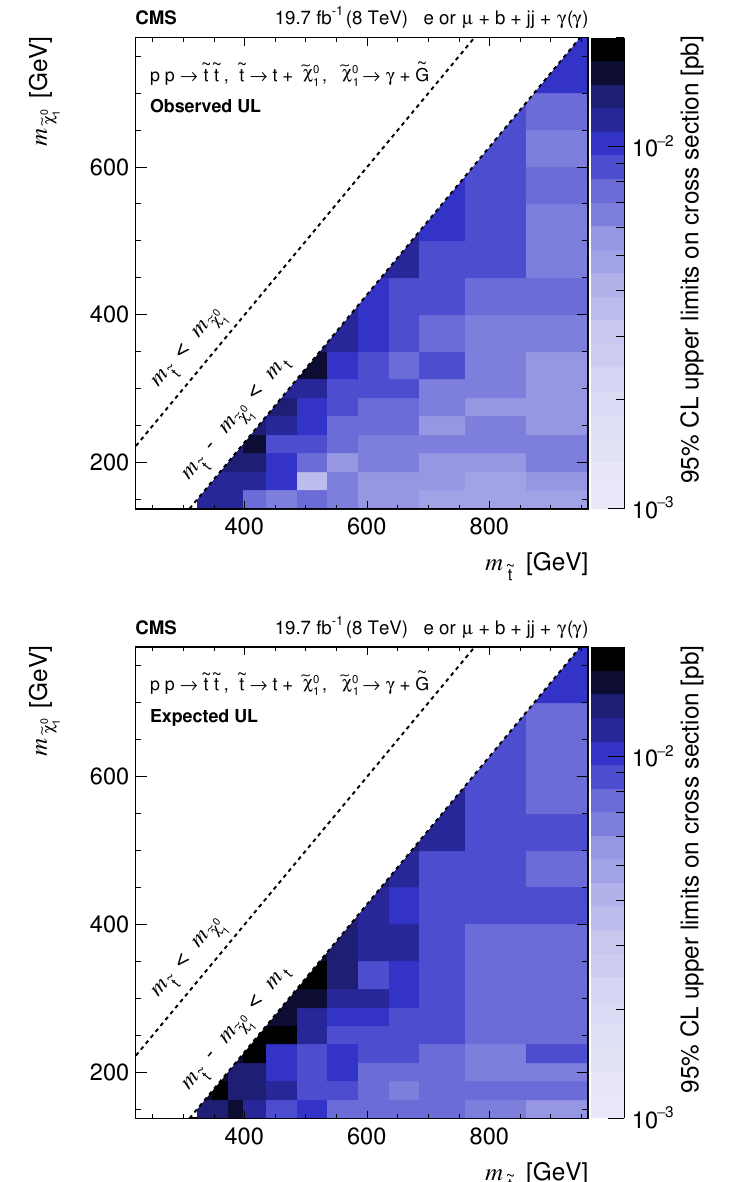
Figure 5 . The observed (upper pane) and expected (lower pane) CL s upper limits on the cross section at 95% CL in the m { m e t e (cid:31) 0 1